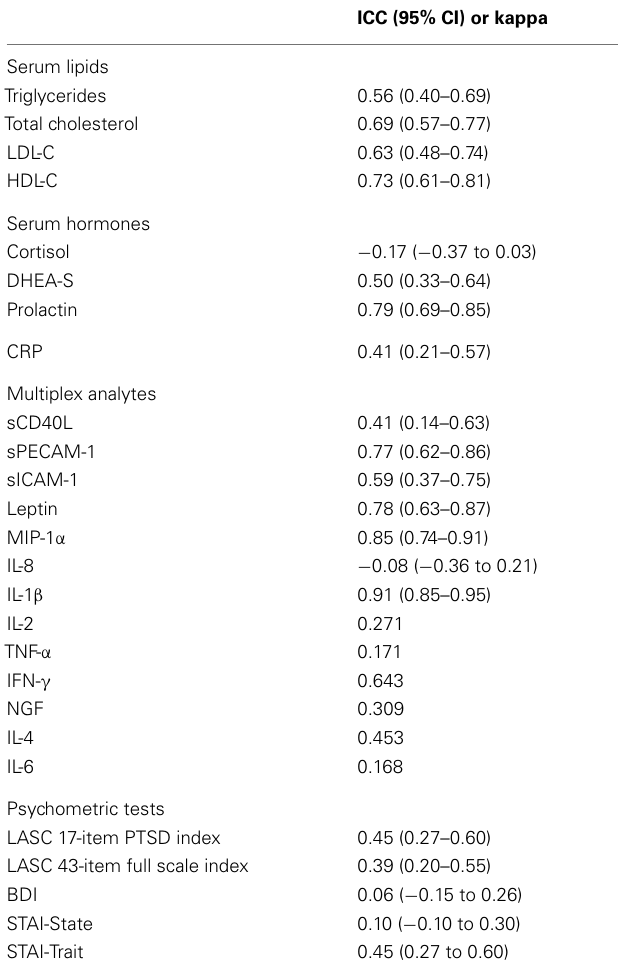
Table 5 | Intraclass correlation coefficient (ICC) and agreement between measurements